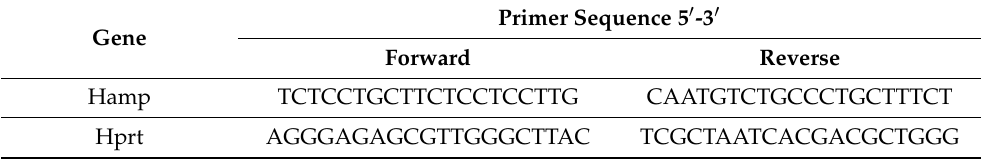
Table 3. Primers for